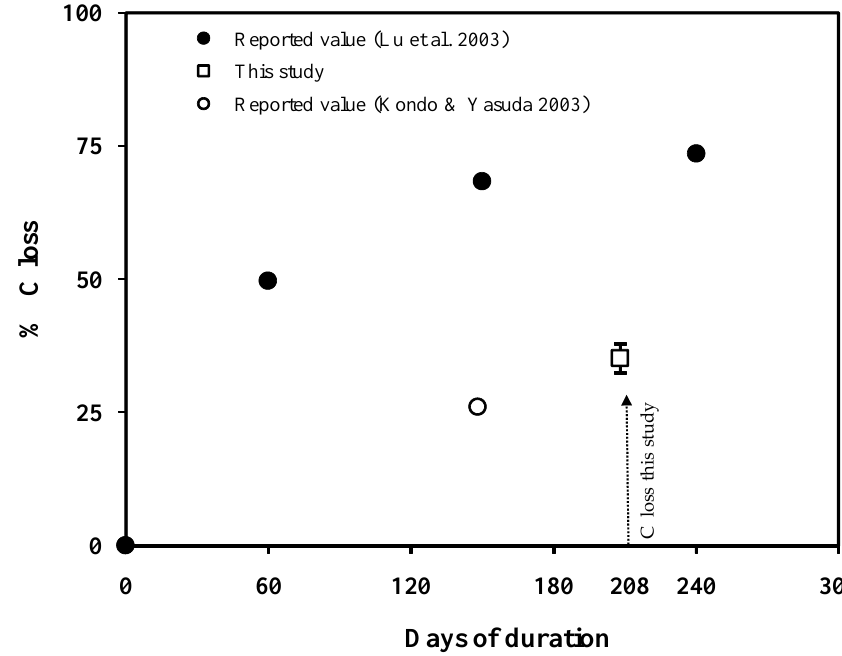
Figure 6. Straw C loss during the winter-fallow period (October to April).